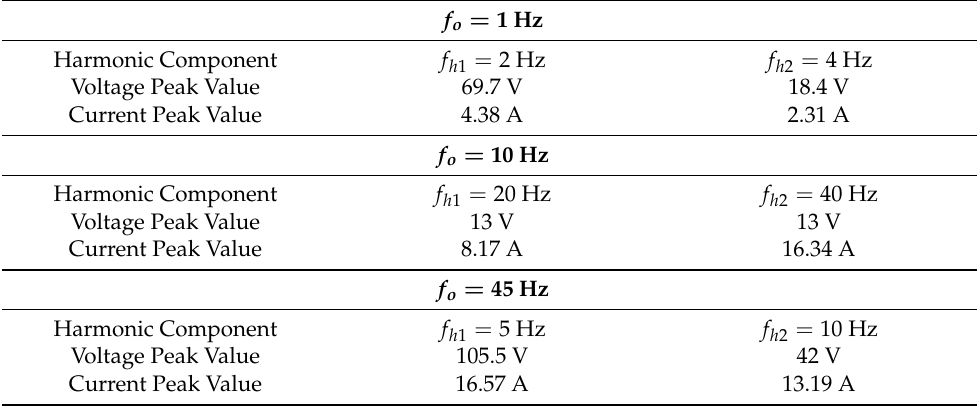
Table 4. Two most influential harmonic components of MMSC submodule capacitor